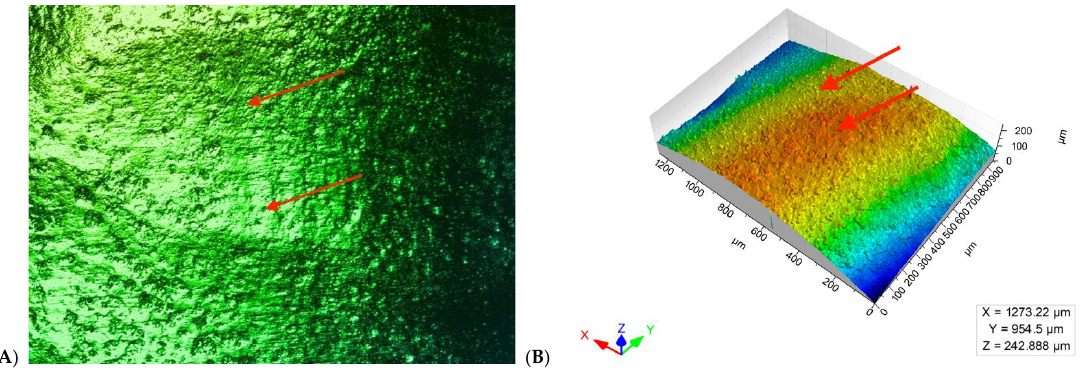
Figure 5. ( A ) Enamel appearance on confocal microscopy after debonding and polishing with a tungsten carbide bur high-speed handpiece (arrows point at the more representative indentations of the enamel surface); ( B ) 3D scheme of surface roughness of the selected representative sample for Group 2 (arrows point at the same area on the representative 3D model of the image’s roughness).